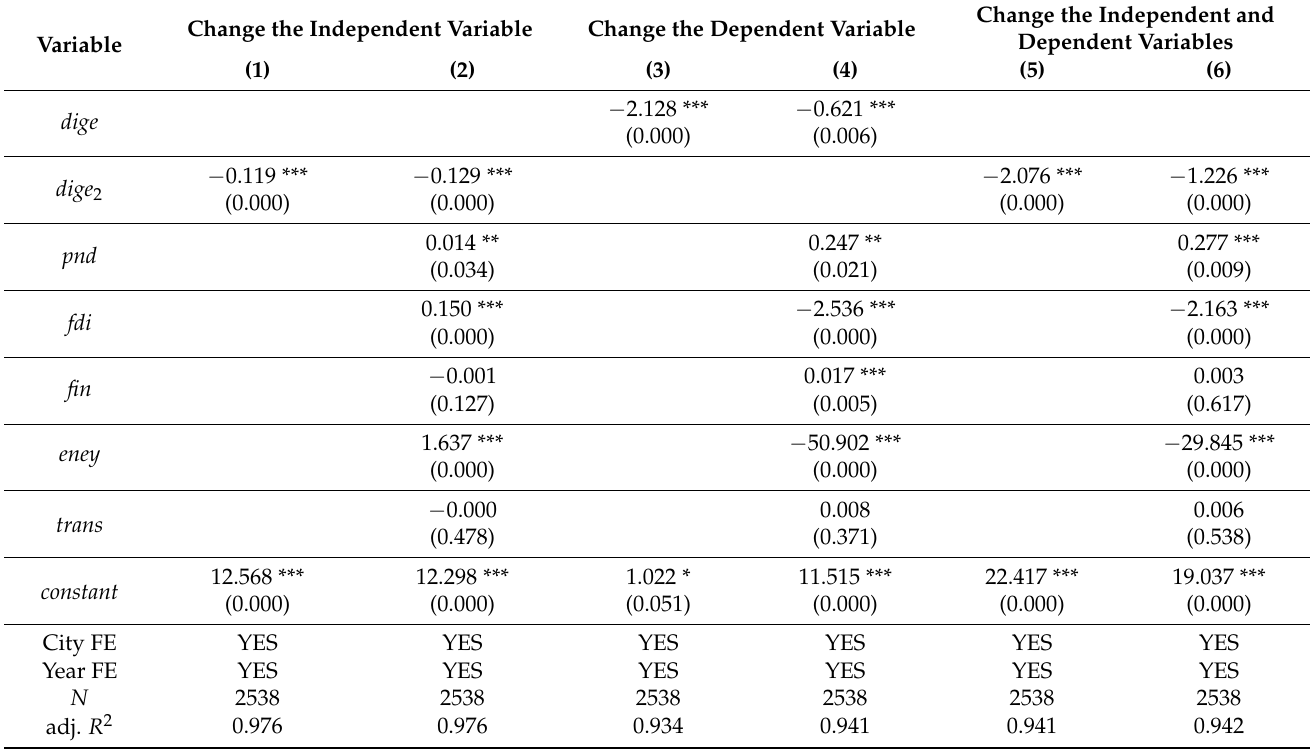
Table 4. Robustness test